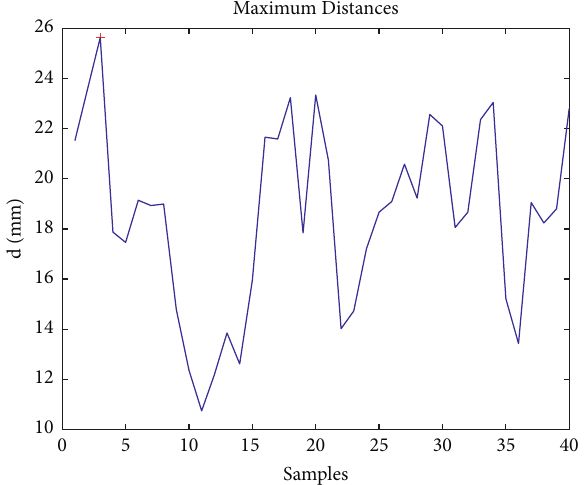
Figure 17: Maximum values of reached distances. Table 1: Motor angles to generate link shrinkage.